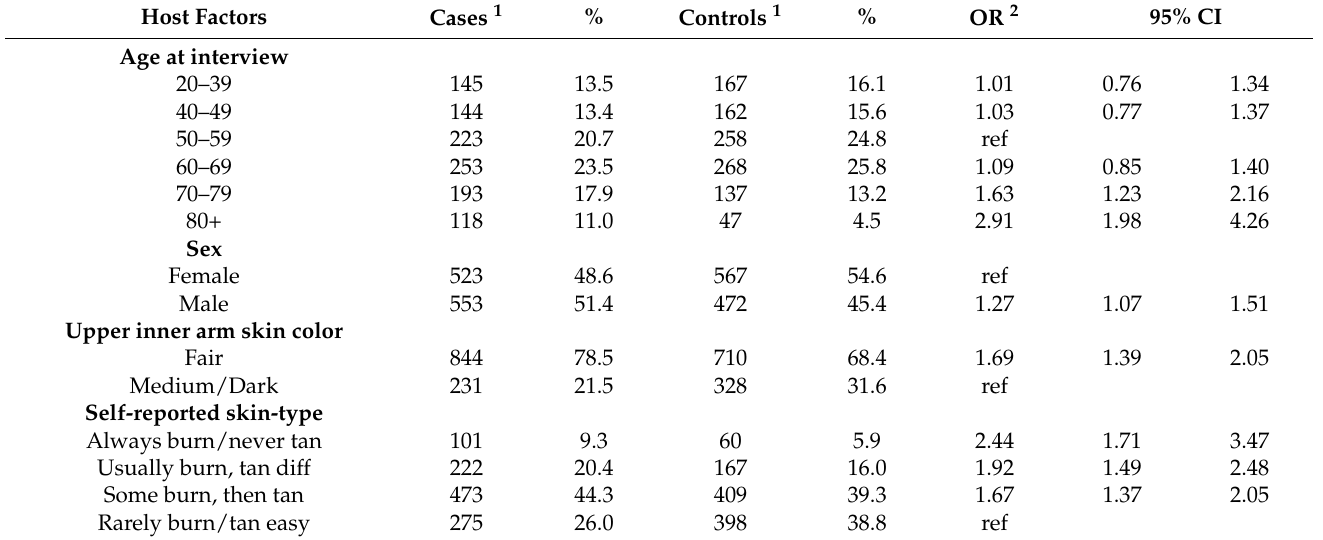
Table 1. Host factors and sun sensitivity measures among 1076 melanoma cases and 1039 population- based controls in